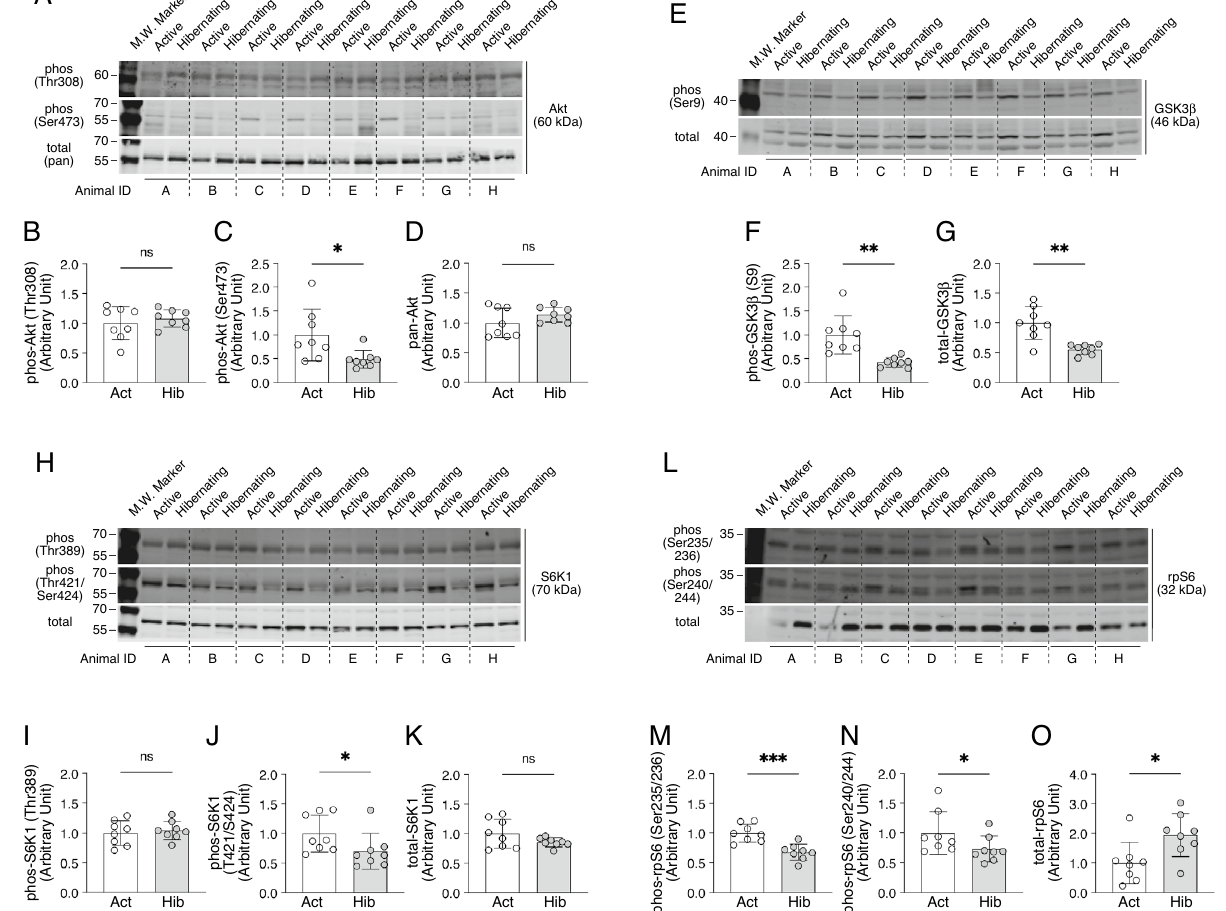
Figure 2. Alterations in the regulatory systems for muscle protein synthesis during hibernation in bears. Typical western blotting images of signaling molecules involved in the regulatory systems for muscle protein synthesis and their quantification results are presented. ( A – D ) phosphorylated (Thr308 and Ser473) and total expression of Akt. ( E – G ) phosphorylated (Ser9) and total expression of GSK3β. ( H – K ) phosphorylated (Thr389 and Thr421/Ser424) and total expression of S6K1. ( L – O ) phosphorylated (Ser235/236 and Ser240/244) and total expression of rpS6. n = 8 in each group. All results are expressed as mean ± standard deviation (SD). Significant differences: *p < 0.05, **p < 0.01, ***p < 0.001 between active versus hibernation Alterations in the regulatory systems for muscle protein synthesis during hibernation. Subse- quently, having found no change in total body weight and muscle fiber size between the active and the hibernat- ing periods in bears, we analyzed how the regulatory system for muscle protein synthesis is altered during hiber- nation (Fig. 2). As for the Akt-glycogen synthase kinase 3 (GSK3) axis of the protein synthesis system, which plays a pivotal role in regulating translation initiation and elongation, phosphorylation of both Akt (Ser473) and GSK3β (Ser9) were significantly decreased in skeletal muscle during hibernation. Another important regulatory system of protein synthesis, the mTORC1-dependent signaling pathway, showed that the phosphorylation status of S6K1 (Thr421/Ser424) and its downstream effector ribosomal protein S6 (rpS6) (Ser235/236 and Ser240/244), which represents the functional activity of mTORC1 signaling, was significantly decreased in skeletal muscle during hibernation. Conversely, the total protein content of rpS6, a potential indicator of intracellular riboso- mal content, was significantly increased during hibernation. Furthermore, the activation status of the mitogen- activated protein kinase kinase (MEK)/extracellular signal-regulated kinase (ERK)-dependent pathway, which is involved in the mTORC1-dependent/independent regulation of muscle protein synthesis, was significantly suppressed with hibernation, as was the reduced phosphorylation status of both signaling molecules (MEK at Ser217/221 and ERK1/2 at Thr202/Tyr204) (Fig. 3A–F). MEK and ERK1/2 phosphorylation are generally con- sidered as an indicator of the mechanical loading of skeletal muscles 16,17 ; hence, it can be considered that a reduc- tion in the phosphorylation status of MEK/ERK reflects a decreased muscle contractile activity or a decreased mechanical loading of the skeletal muscles during hibernation. We also examined the phosphorylation of p38, another MAPK family member that is implicated in myogenesis and the differentiation and proliferation of myogenic cells, and found a marked decrease in phosphorylation associated with hibernation in the skeletal muscles of bears (Fig. 3G–I). Overall, these data imply that, although the indicator of ribosomal content (i.e.,